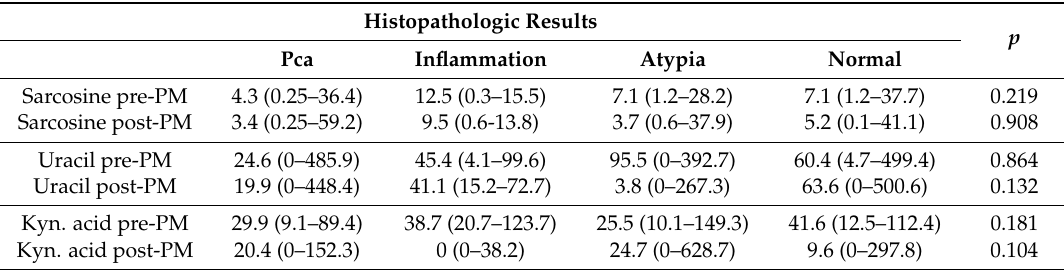
Table 5. Endogenous metabolites according to histopathologic results—group B. Values are presented as medians/ranges in µ g/L.